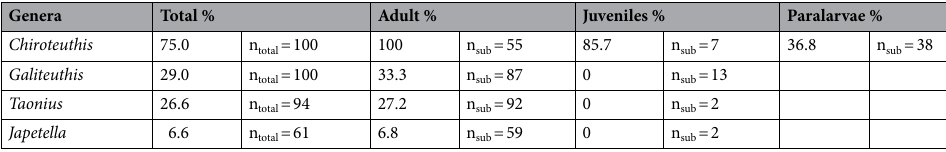
Table 1. Prevalence estimate of H. cf. moroteuthensis in midwater cephalopods, as the percentage of video observations where gills were clearly visible. n total , number of video observations for each taxon; n sub , number of video observations per life stage.